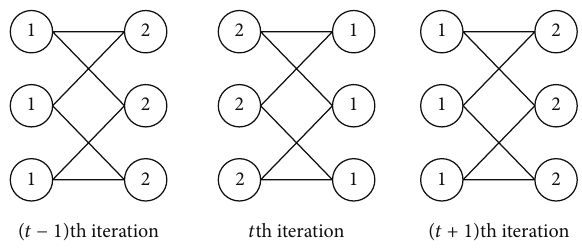
Figure 1: The oscillation of labels in a bipartite